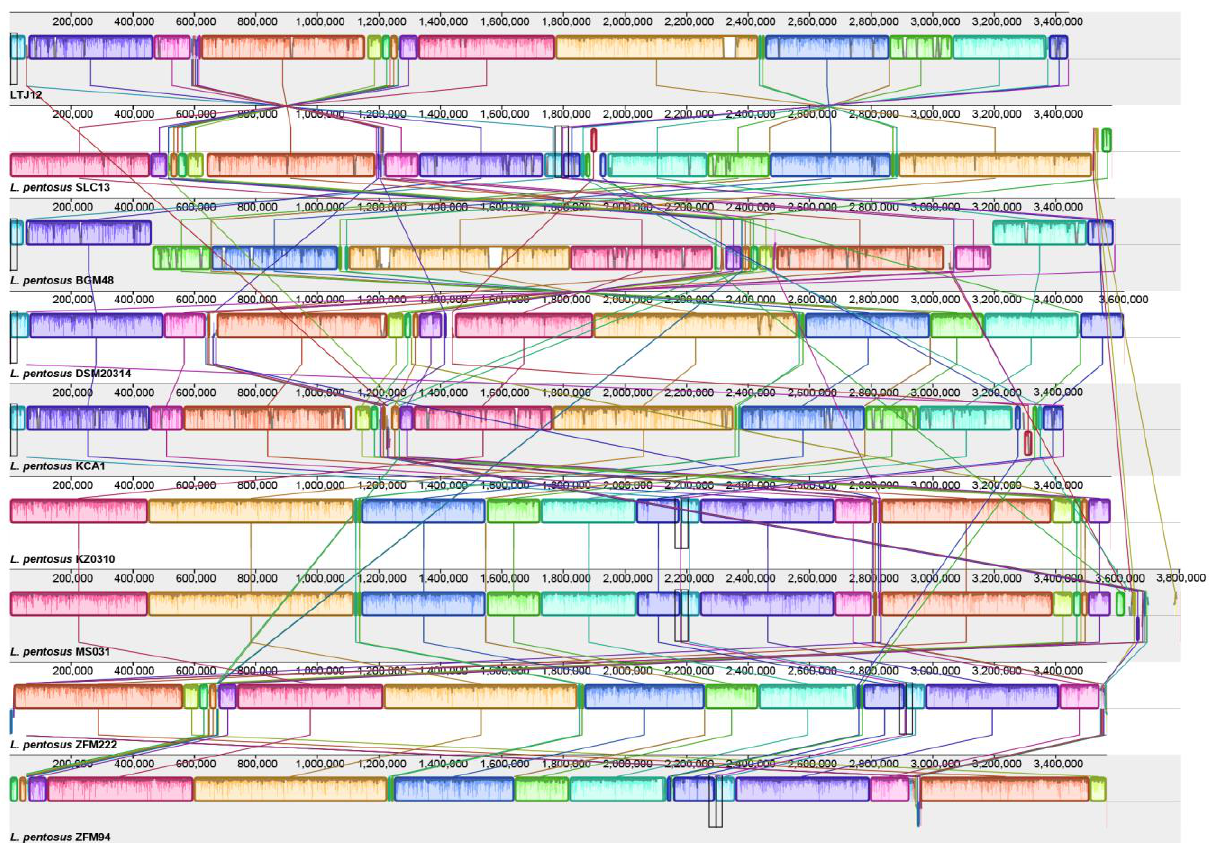
Figure 8. Mauve Alignment of all L. pentosus genomes available in the NCBI database. L. plantarum WCSF1 was isolated from human saliva and first sequenced in 2001, and